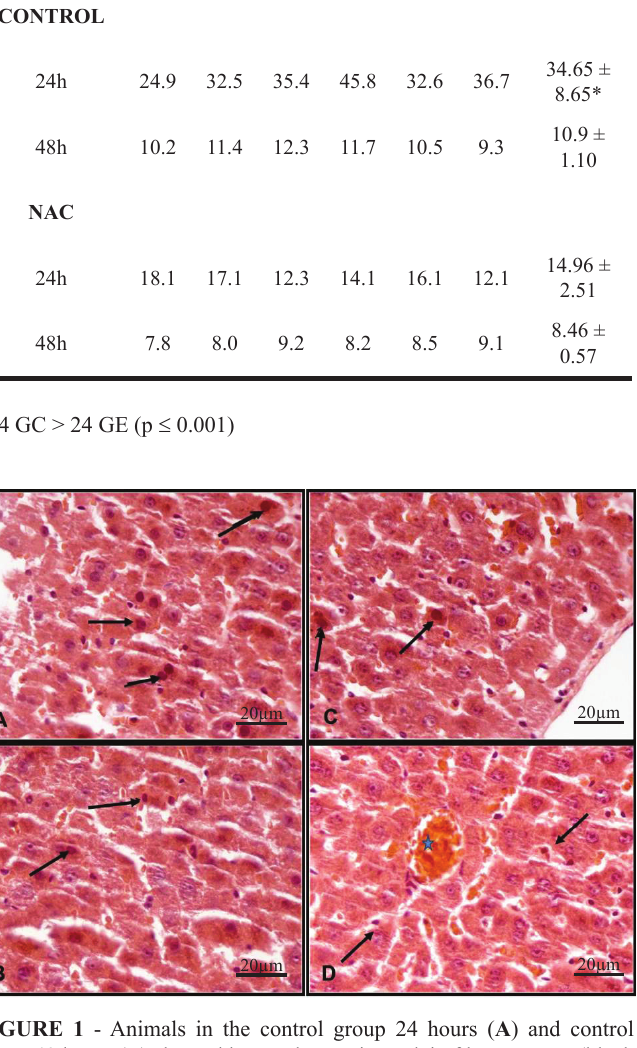
FIGURE 1 - Animals in the control group 24 hours ( A ) and control group 48 hours ( B ) showed heterochromatic nuclei of hepatocytes (black arrows). Animals in Group NAC 24 hours ( C ) and 48 hours ( D ) showed some heterochromatic nuclei of hepatocytes (black arrows). Note lobular vein center congested at group 48 hours ( D ) (star). (HE-400 X).